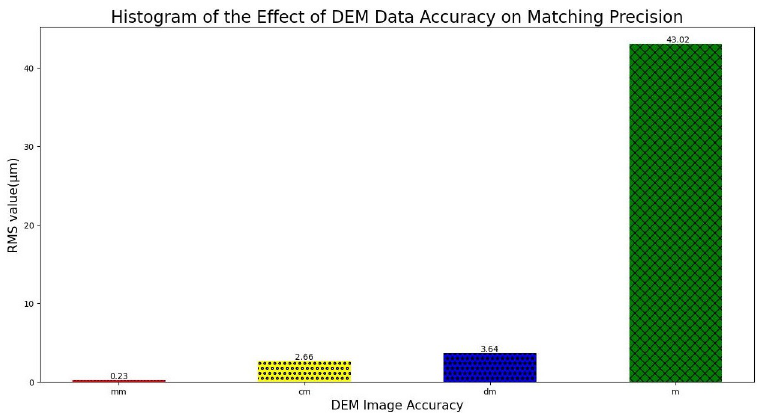
Fig 21. Histogram of root mean square error of DEM image accuracy versus matching